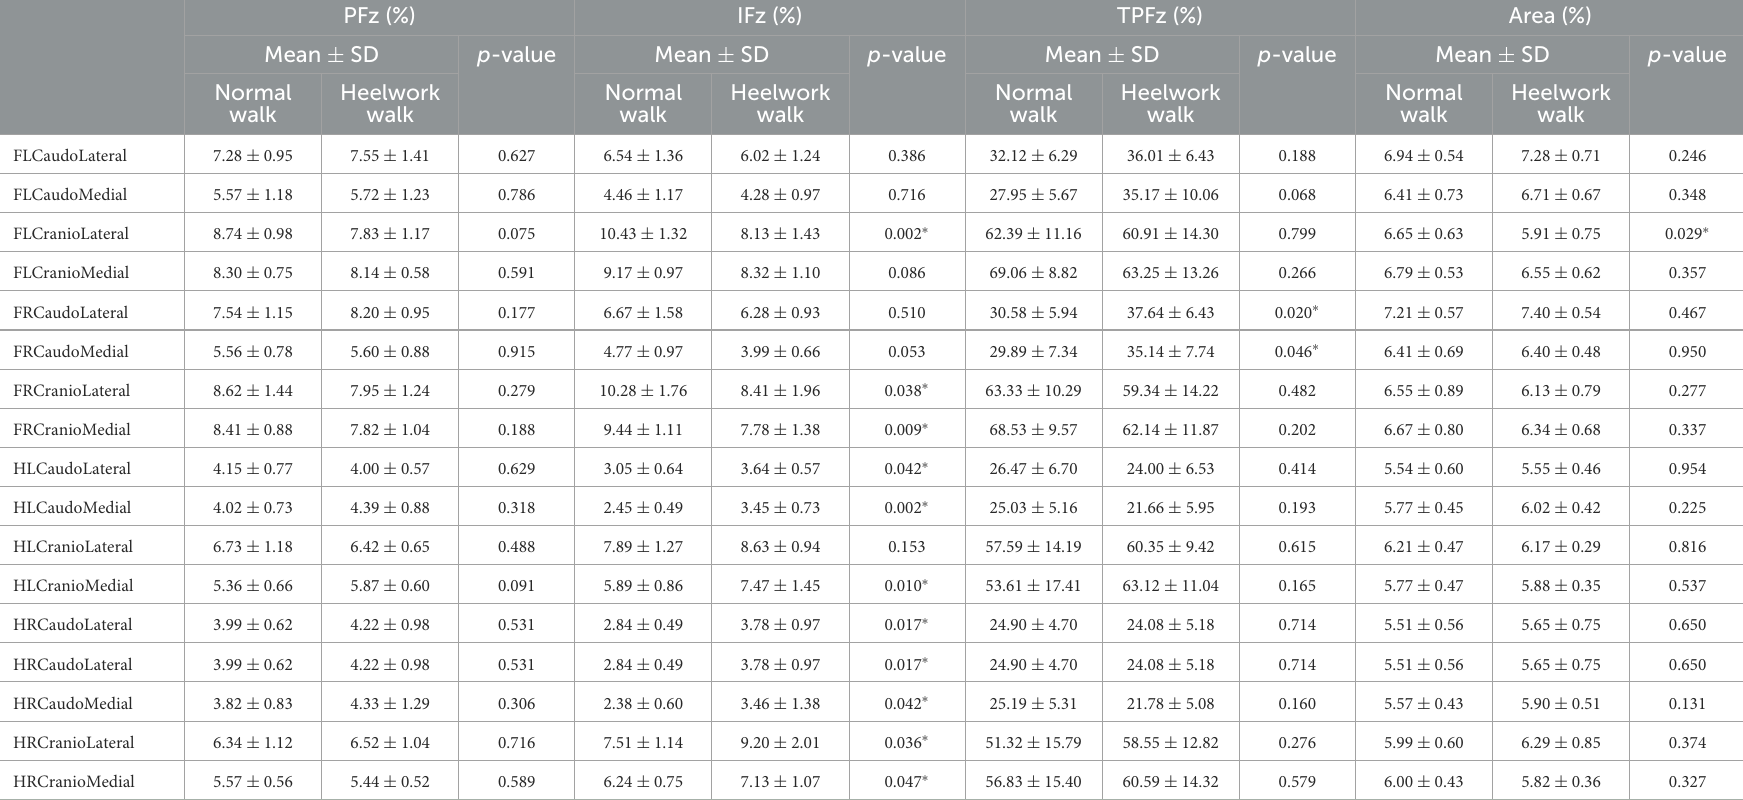
TABLE 6 Mean values, standard deviation, and significant differences of the ground reaction forces in the quadrants between normal walking and heelwork